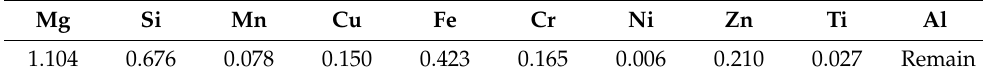
Table 1. Chemical compositions of the as-received 6061-T6 aluminum alloy (wt. %).